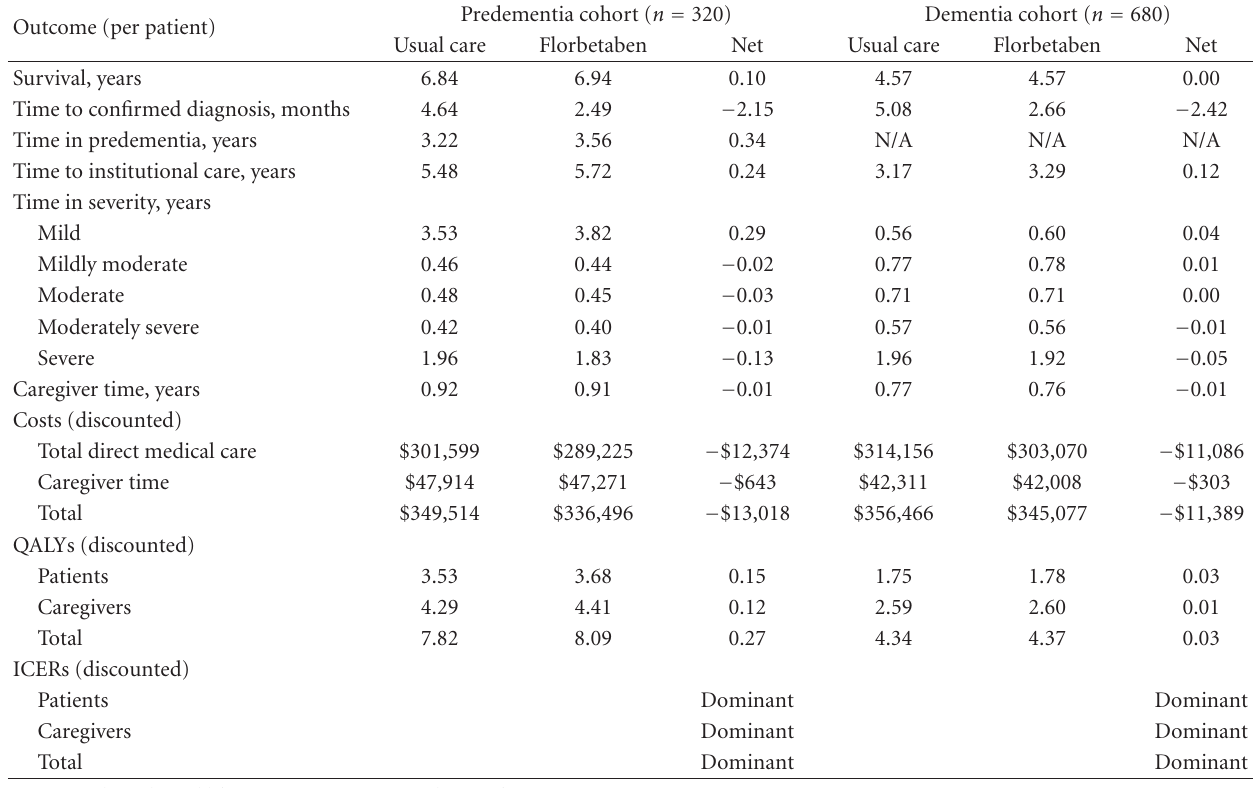
Table 5: Reference-case